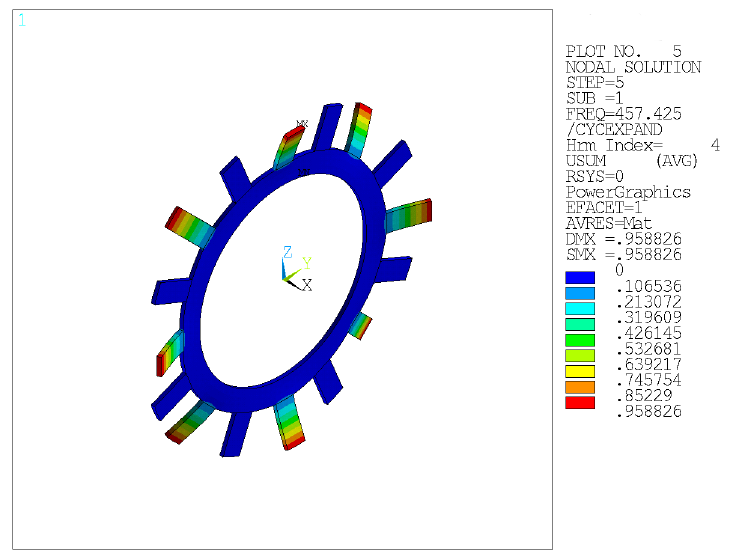
Figure 3. First bending mode of the dummy test case (ND = ± 4).